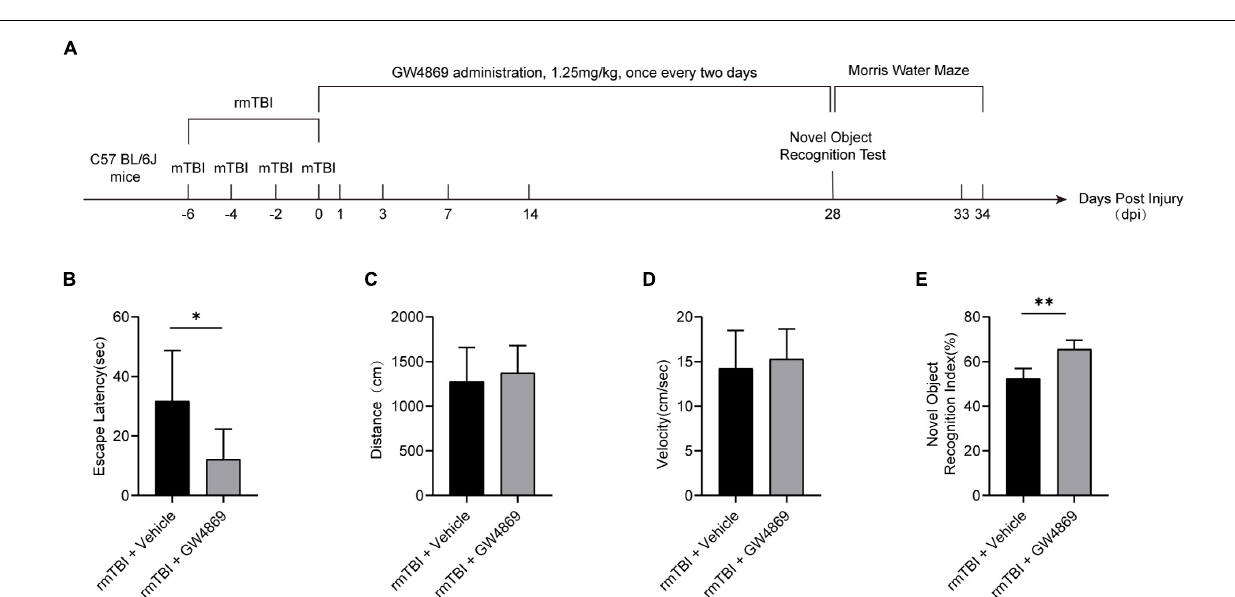
FIGURE 2 | (A) Flow chart showing GW4869 administration and experimental design. C57BL/6J mice were subjected to rmTBI before GW4869 treatment. Immediately after rmTBI, the mice received GW4869 (1.25 mg/kg) or the same volume of 0.9% NaCl vehicle by intraperitoneal (IP) injection once every two days. A novel object recognition test was conducted at 28 dpi after rmTBI, and a Morris water maze test was conducted at 28–34 dpi after rmTBI. (B–D) Mice with rmTBI treated with GW4869 spent less time finding the platform during the Morris water maze test, but the swimming velocity and distance travelled were not